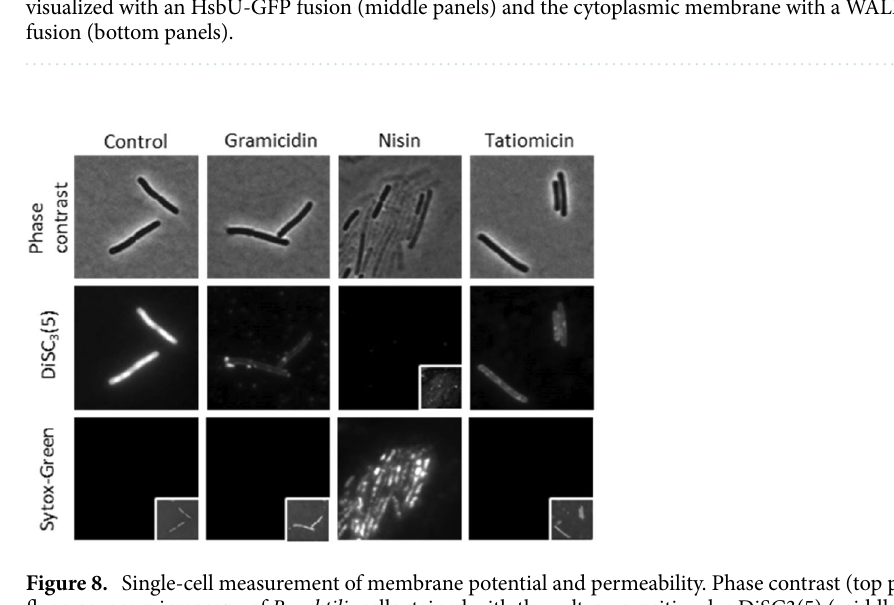
Figure 8. Single-cell measurement of membrane potential and permeability. Phase contrast (top panels) and fluorescence microscopy of B. subtilis cells stained with the voltage-sensitive dye DiSC3(5) (middle panels) and the membrane permeability indicator Sytox Green (bottom panels) in the presence and absence of 32 μg/mL of tatiomicin. As positive controls, the cells were treated with 5 μg/mL of gramicidin (membrane depolarisation without pore formation) and 10 μM nisin (membrane depolarisation through pore formation). Cellular DiSC3(5) and Sytox Green fluorescence values were quantified for cells treated with tatiomicin (32 μg/mL), gramicidin (5 μg/mL), and nisin (10 μM) (see